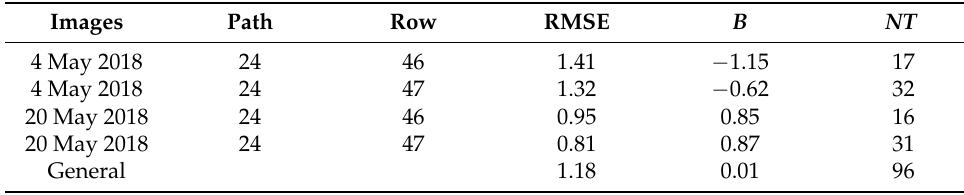
Table 3. Errors of the temperature fields obtained from RS data. Images Path Row RMSE B NT